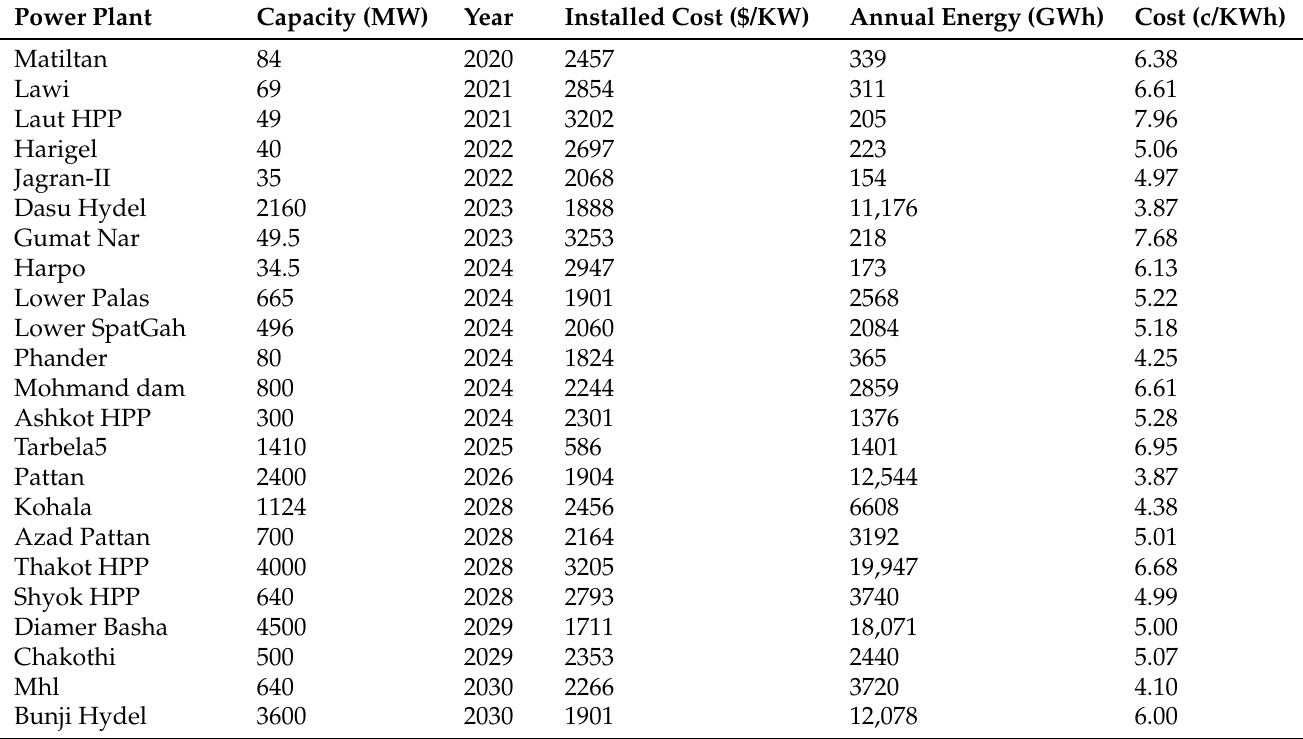
Table 7. Government initiatives under SDG 7 for hydropower